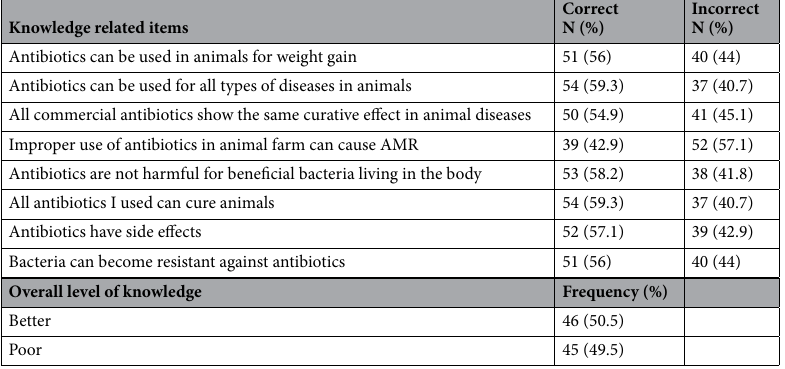
Table 3. Knowledge of animal farm owners/workers towards antimicrobial resistances and use in Amhara regional state, North Western Ethiopia (N = 91).